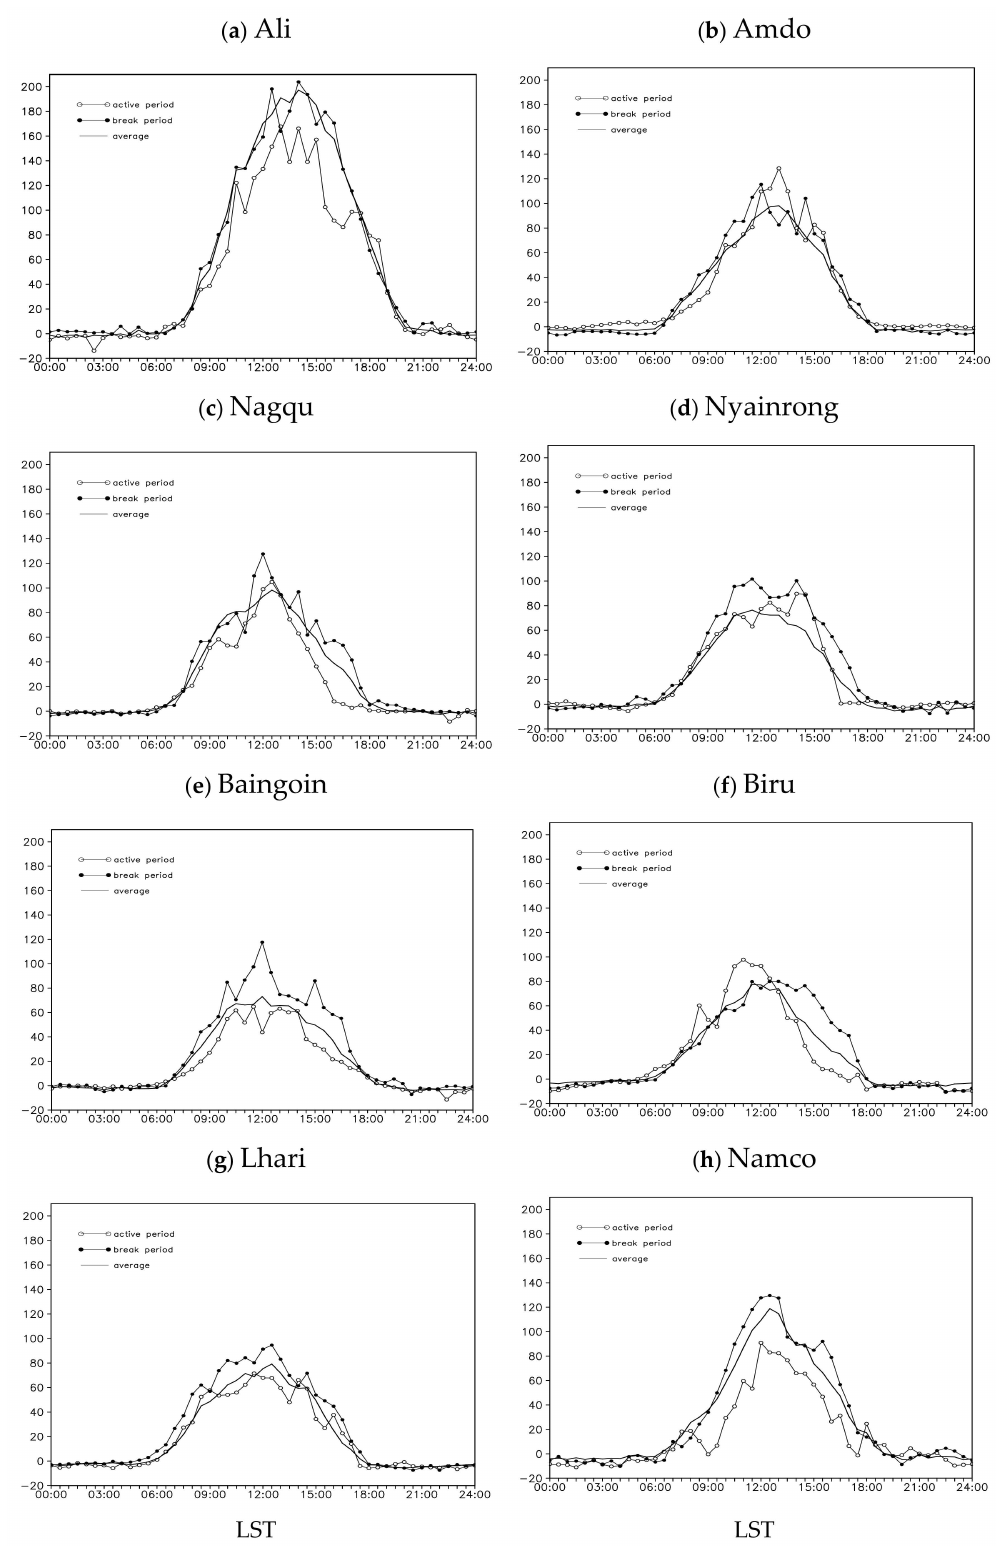
Figure 7. Diurnal variations of the sensible heat flux (SH) (units: Wm − 2 ) from 8 stations, averaged for the observations and SASM active and break